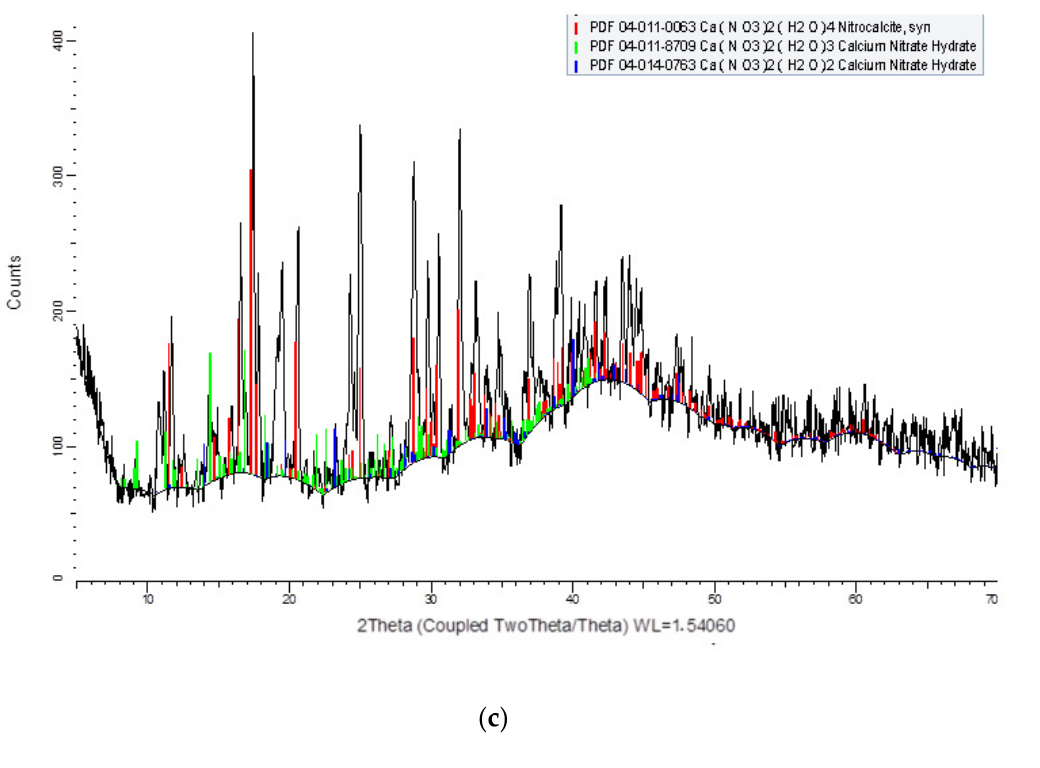
Figure 1. Cement, MSS and NC X-ray diffractogram. ( a ) Cement, ( b ) sodium silicate (MSS) and ( c ) calcium nitrate